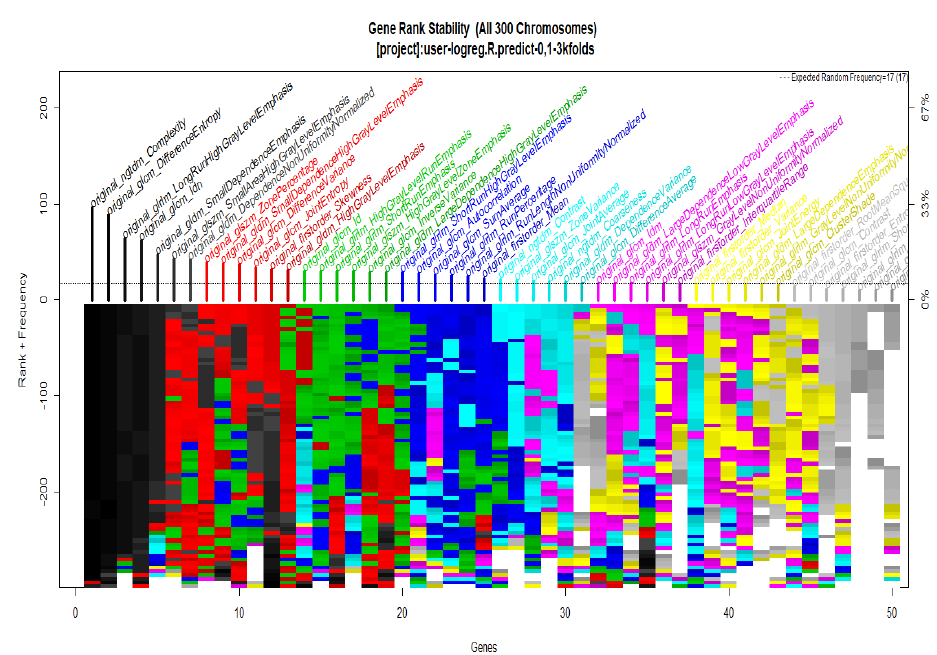
Figure 11. Gene Rank Stability graph with calcification model by radiologist segmentation; the gene rank shows the stability of the top-ranked 50 variables. The horizontal axis shows the genes ordered by rank, and the vertical axis shows the gene frequency. The bottom color—coded rank represents the genetic stability where features with no change in color represent a stable feature; changing color features represent unstable features.